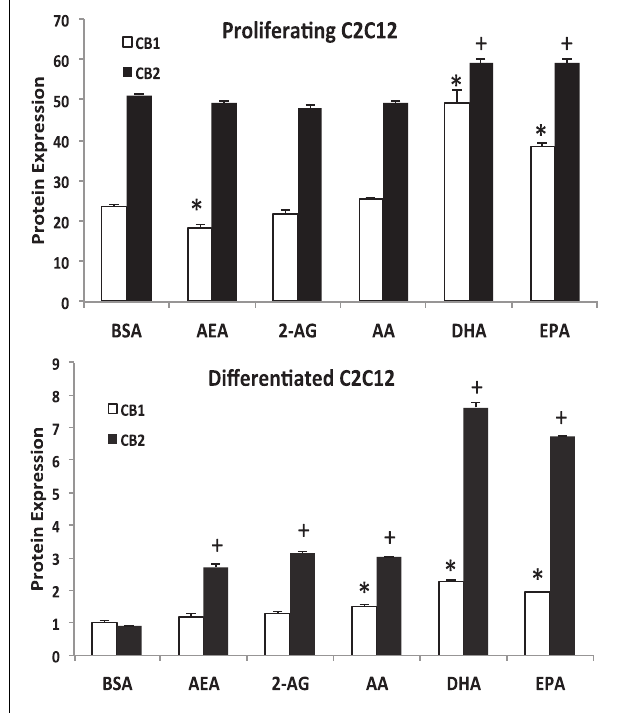
FIGURE 1 | Western blot analysis of CB1 and CB2 expression in proliferating and differentiated C2C12 myoblast cultures treated with PUFA and EC. C2C12 cultures were treated with 25 μ M of respective treatments for 24h. The bars are the means ± SD (error bars) of 2 experiments performed in triplicate. The asterisk ( ∗ ) signifies difference compared to the BSA control for CB1 while the plus sign ( + ) indicates difference compared to the BSA control for CB2. In proliferating cells compared to the BSA vehicle control, DHA and EPA values for both receptors were higher; CB1 was lower in the AEA treatment. In differentiating cells compared to the BSA vehicle control, all treatments showed higher CB2 protein expression but only AA, DHA and EPA treatments were higher for